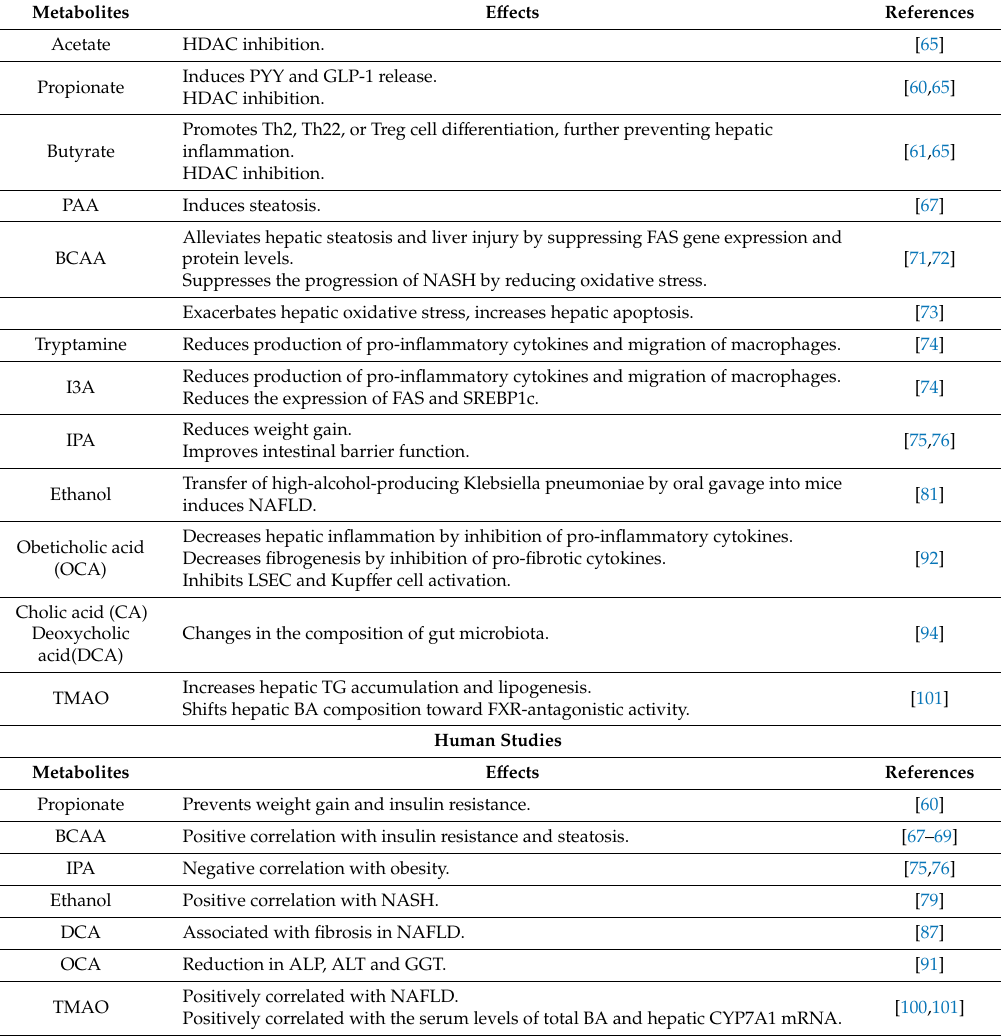
Table 1. Overview of metabolite-relative e ff ects on host in in vitro and animal models.